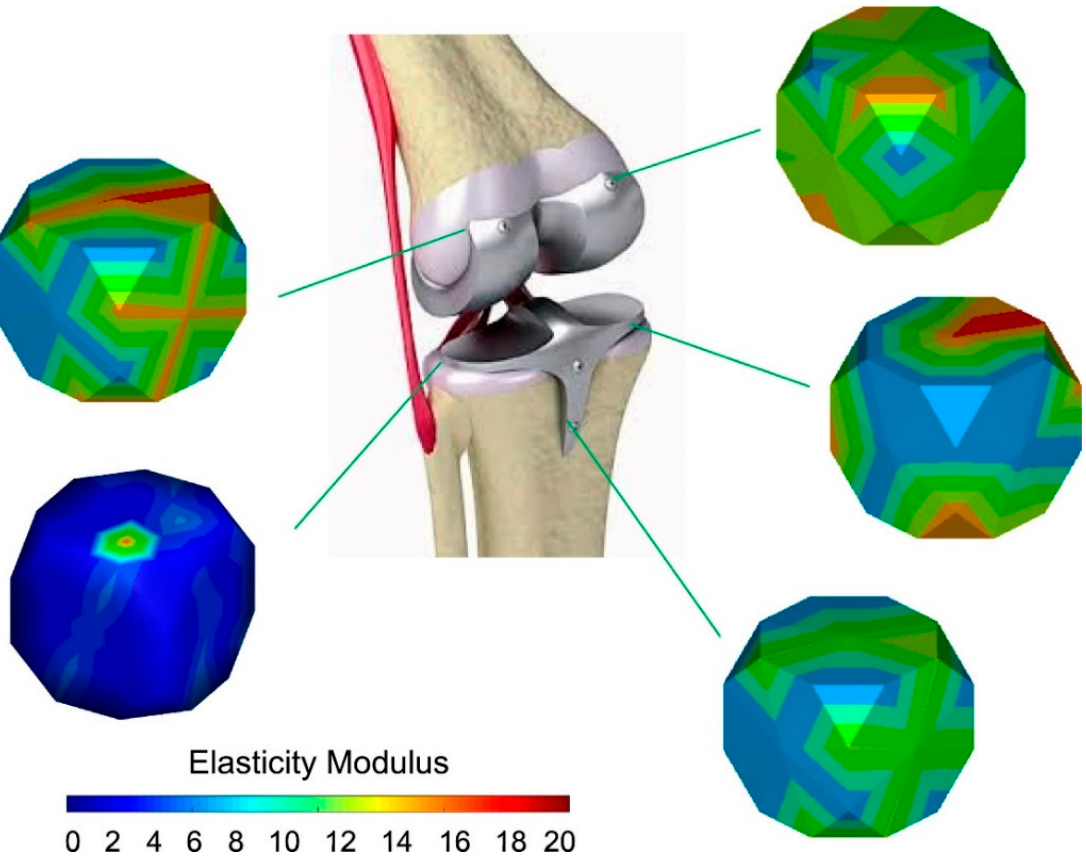
Figure 1. Design of the elastic modulus by changing the material microstructures. Reproduced with permission from [25], copyright Elsevier, 2020.